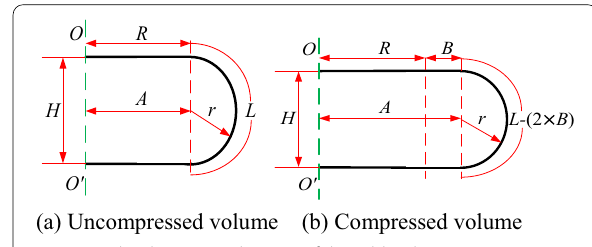
Figure 8 The dimension diagram of the rubber housing